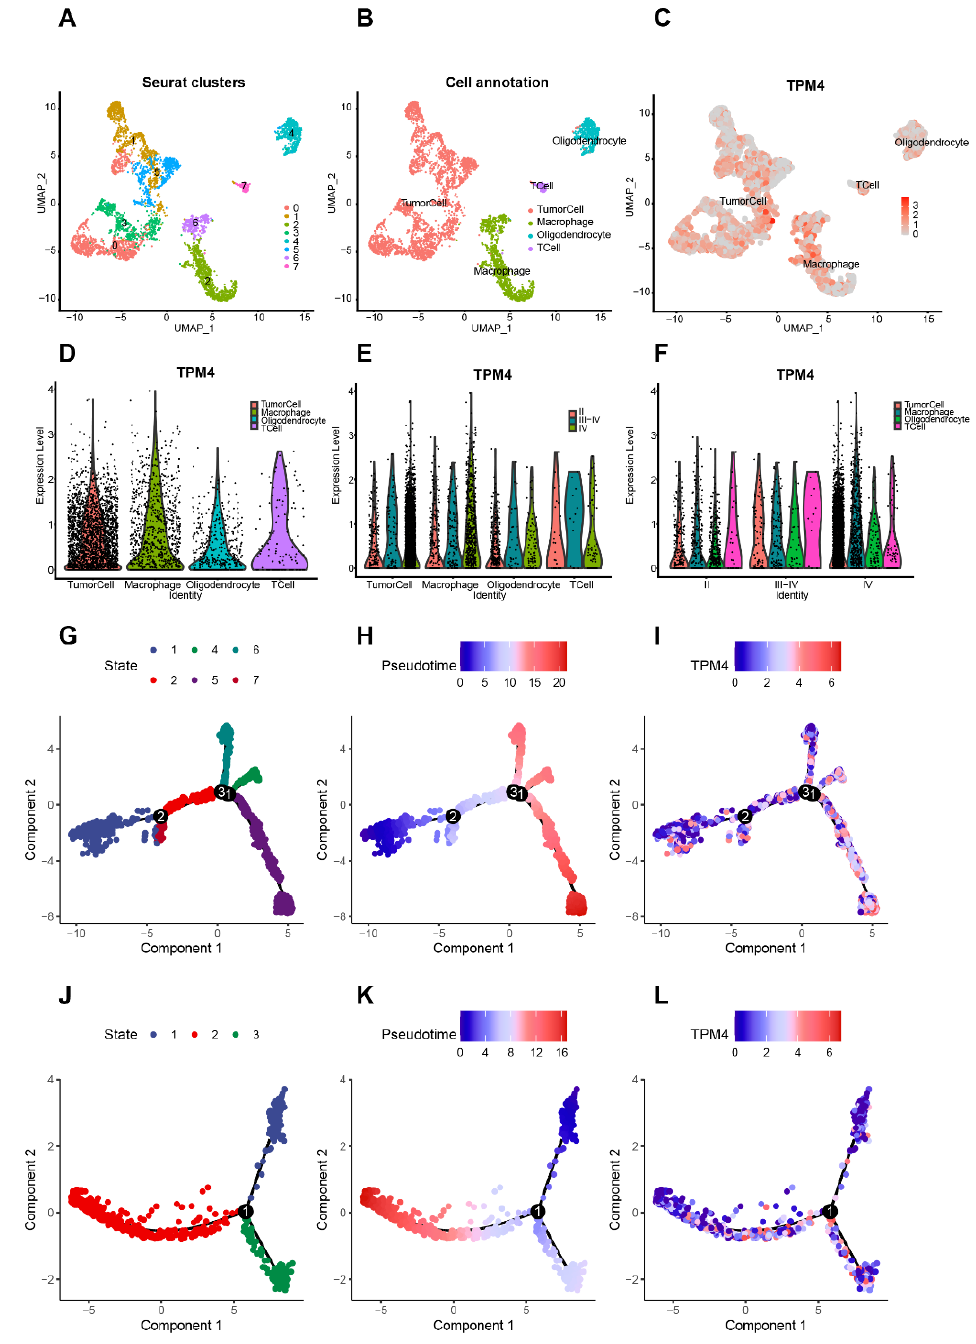
Figure 6. TPM4 expression on different cell types based on CGGA scRNA-seq data. ( A ) Eight cell types were clustered with Seurat package. ( B ) Cell annotation according to cell markers (Figure S3). Clusters 0, 1, 3, and 5 overexpressing PDGFRA and EGFR were annotated as tumor cells. Clusters 2 and 6 highly expressing CD68 and C1QC were annotated as the monocyte-macrophage linage, and cluster 4 overexpressing MOG was concluded as oligodendrocytes. Cluster 7, highly expressing CD3D and CD3E, represented a series of T cells. ( C ) Dimplot of TPM4 expression across different cell types. ( D ) Vlnplot of TPM4 expression across different cell types. ( E , F ) TPM4 expression across different subgroups. ( G – I ) Single-cell developmental trajectory analysis of tumor cells revealed seven states. Cells were colored based on states ( G ), pseudotime ( H ), and TPM4 expression ( I ). ( J – L ) Single-cell developmental trajectory analysis of macrophages. Cells were colored based on states ( J ), pseudotime ( K ), and TPM4 expression ( L ). In pseudotime developmental trajectory analysis, the black circled numbers indicates different branch points.